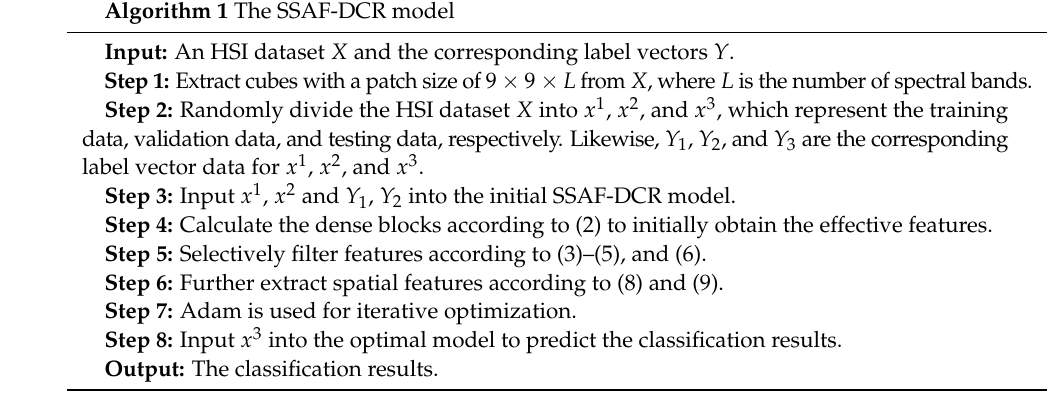
Algorithm 1 The SSAF-DCR